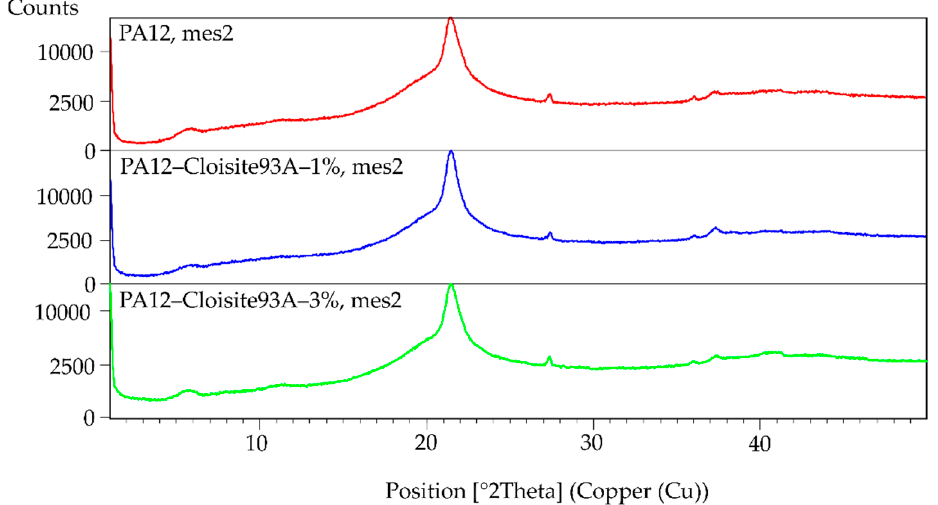
Figure 3. XRD graphs of PA12, PA12/1% of Cloisite 93A and PA12/3% of Cloisite 93A.